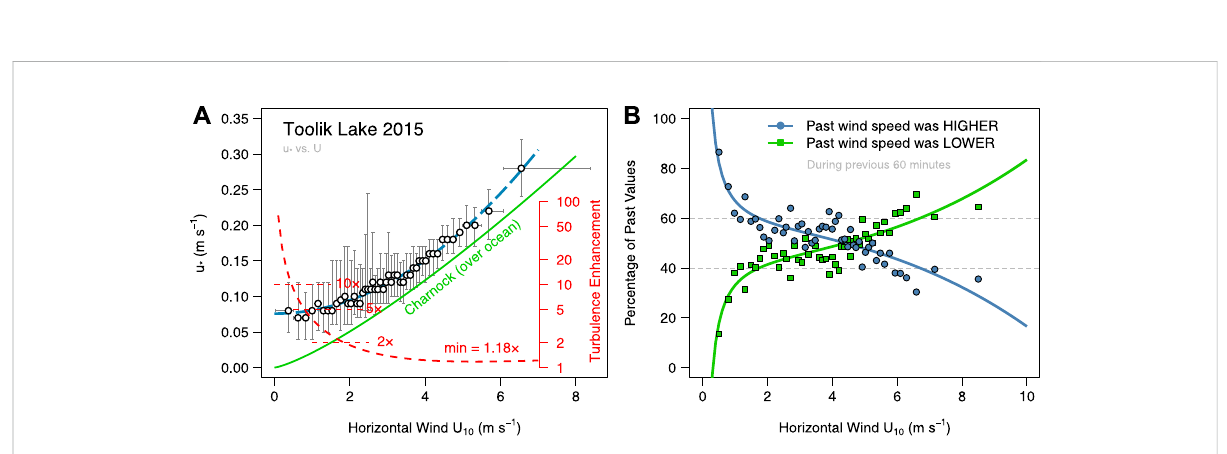
FIGURE 10 Turbulentmixing (A) (expressedbyfrictionvelocityu * asafunctionofhorizontalwindspeed)issubstantiallyenhancedoverlimited-sizedToolik Lakeascomparedtothewidely-usedCharnock-relationshipoveropenoceanwatersurfaces.Moreover, (B) variabilityofhorizontalwindspeedover Toolik Lake is high, with past wind speeds (last 60 min) typically having been greater than actual wind speeds < 4.4 m s − 1 . The red dashed line in (A) shows the ratio between measurements ( fi t to group means) and the expected u * according to Charnock.